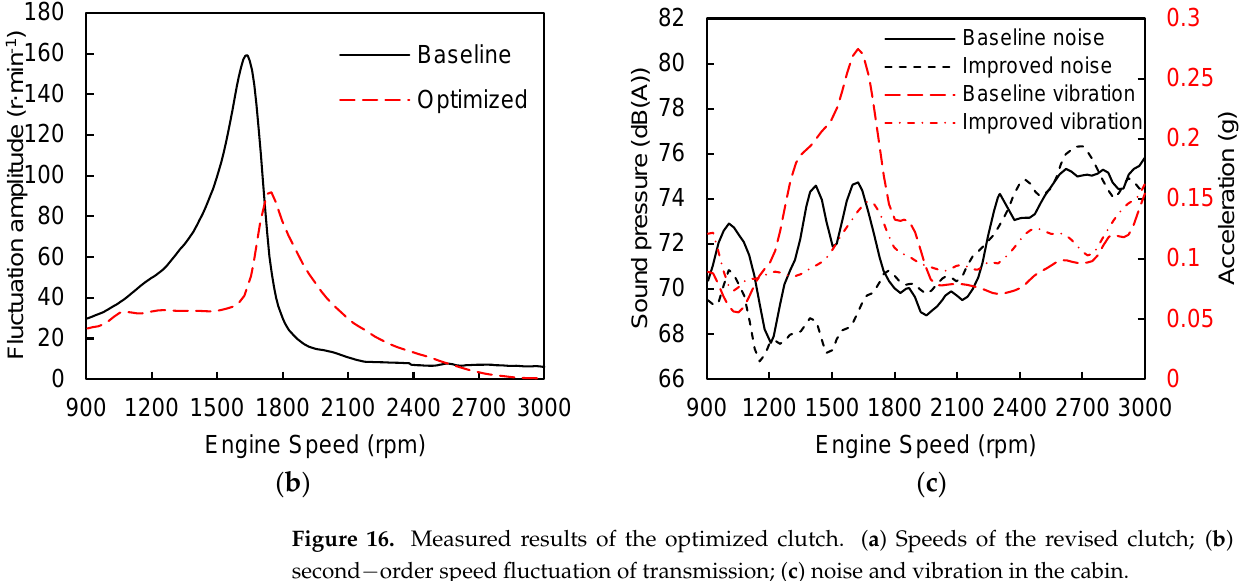
Figure 16. Measured results of the optimized clutch. ( a ) Speeds of the revised clutch; ( b ) the second − order speed fluctuation of transmission; ( c ) noise and vibration in the cabin.